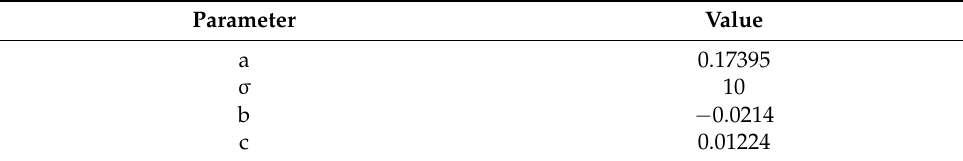
Table 3. Creep model parameters.